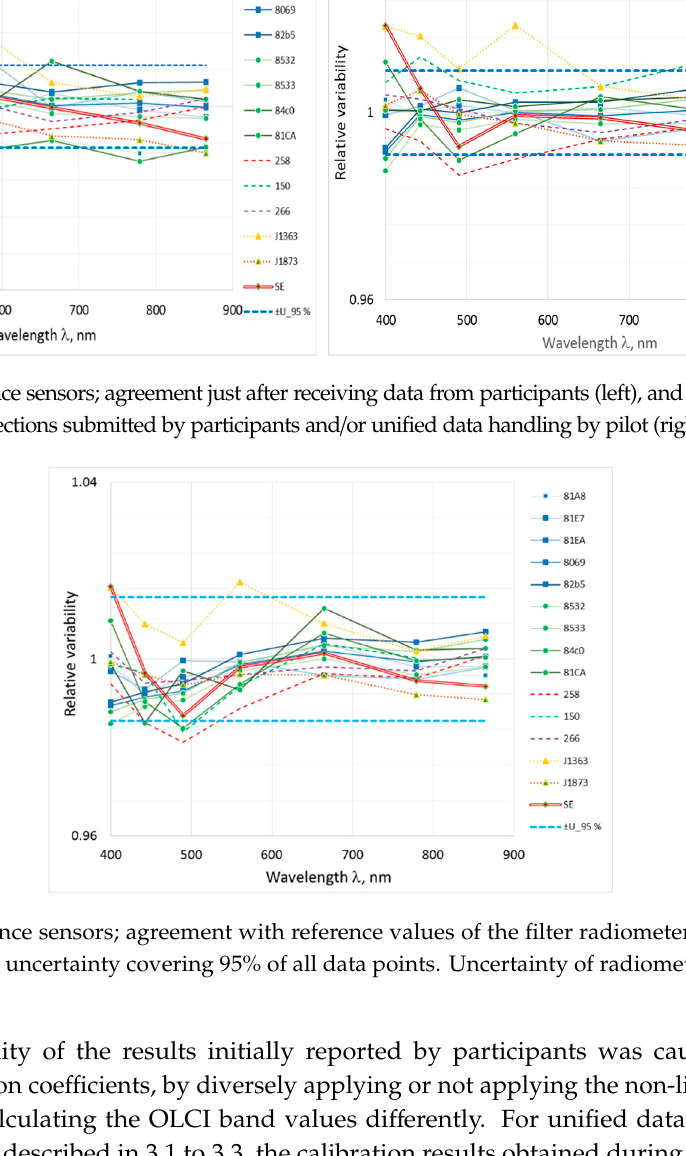
Figure 6. High intensity radiance; agreement just after receiving data from participants (left), and after reviewing data by pilot, corrections submitted by participants and/or unified data handling by pilot (right).